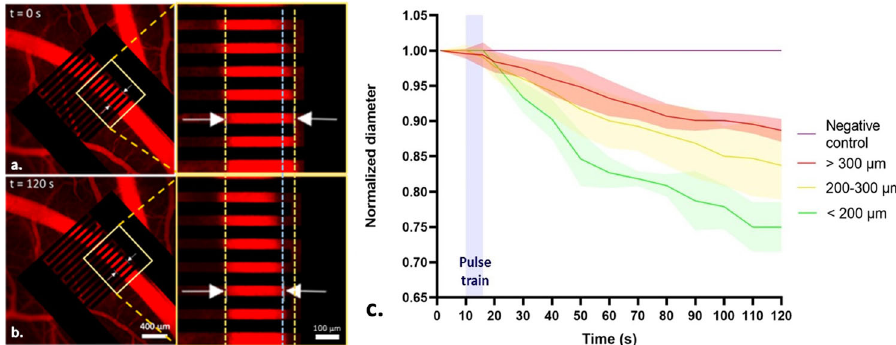
Fig. 4 Vasoconstriction induced by fl exible electronic delivery of PEFs. a , b view from the top of the device placed on the vascularized tumor and a zoom on the region of interest at the beginning ( a ) and the end ( b ) of the experiment. Texas Red dextran was injected into the vascular circulation to visualize blood vessels with fl uorescence microscopy at λ exc = 595 nm. White arrows show the location of the measure, performed between the dotted lines depicting the edges of the blood vessel at the beginning (yellow) and the end (blue) of the experiment. Scale bars: ( a , b ) left panel: 400 µm, right panel: 100 µm. b Normalized diameter over time after PEFs delivery (5 pulses – 20 V – 100 µs – 1 Hz) depending on the blood vessel diameter. The pulse train is represented in blue. Negative control: N = 3, large blood vessels: N = 6, medium blood vessels: N = 11, small blood vessels: N = 3. Error bars indicate standard